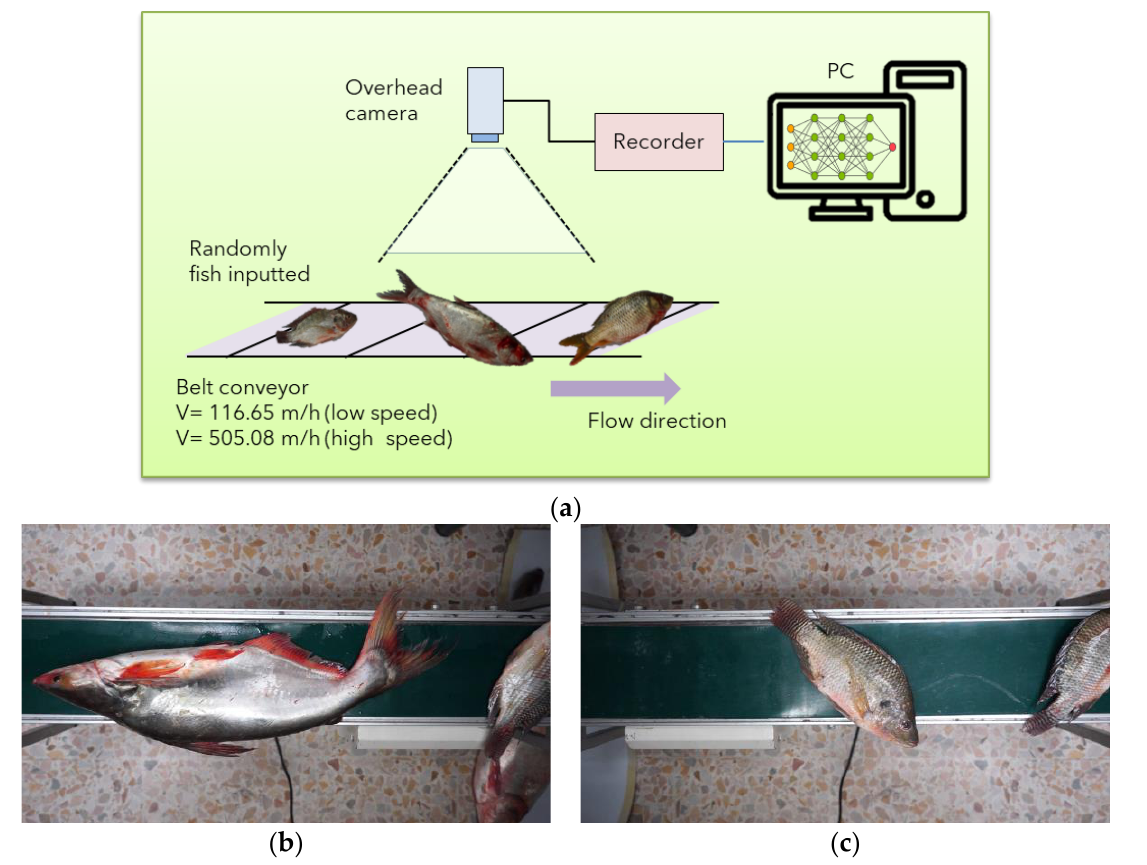
Figure 2. The experimental set-up for: ( a ) taking the videos; while ( b , c ) are examples of capturing video results. Table 1. Images dataset (static pictures).